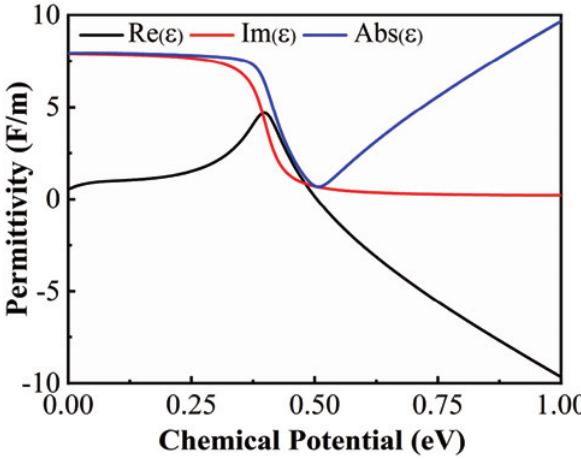
Figure 3: Permittivity of graphene as the function of chemical